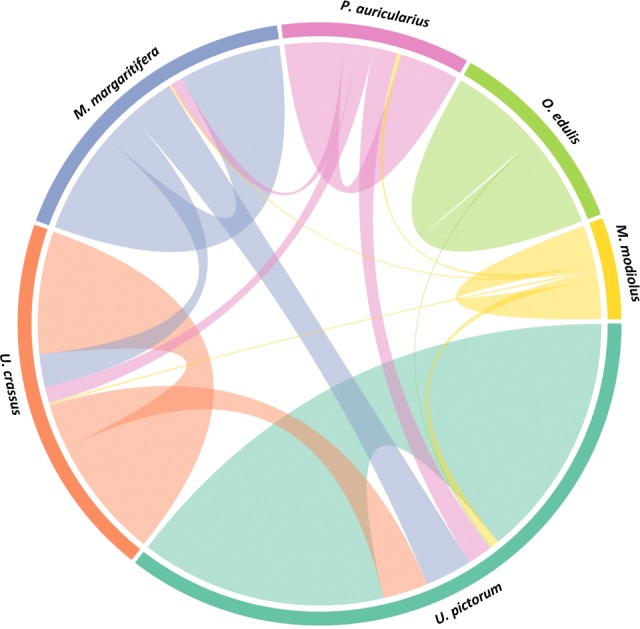
Circular diagram representing the extent of similarity between the proteomes of six reference mollusc shells based on the identified EST sequences.